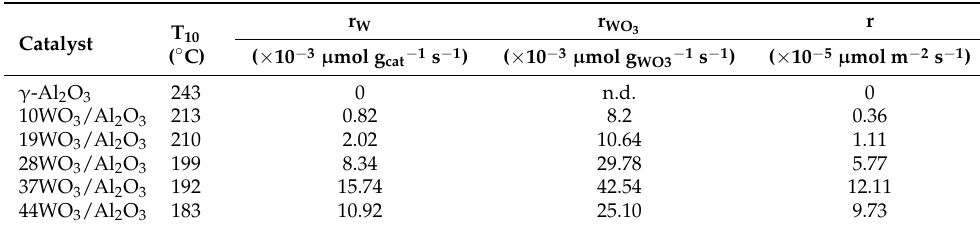
Table 3. Catalytic performance of WO 3 /Al 2 O 3 in DME hydrolysis expressed as the temperature at which 10% conversion was obtained (T 10 ) and reaction rates expressed per catalyst weight, WO 3 weight and specific surface area, r W , r WO and r, 3